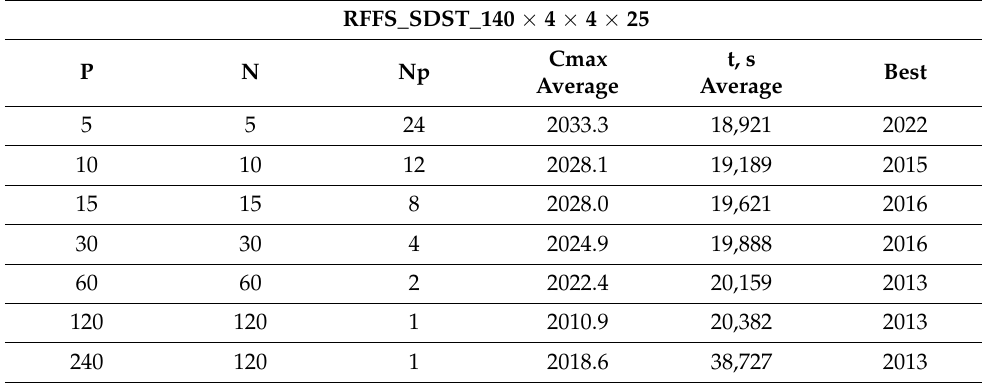
Table 11. RFFS_SDST_80 × 4 × 4 × 25